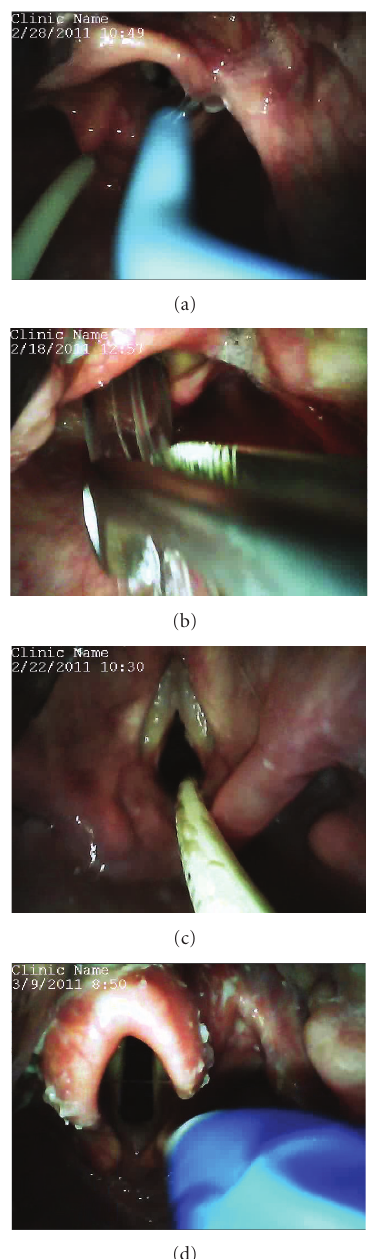
Figure 4: Examples of unique situations where the GlideScope Direct was found to be useful. (a) Endotracheal intubation with the aid of a bougie. (b) Nasotracheal Intubation with the use of Magill forceps. (c) Endotracheal tube exchange with the a Cook Airway Exchange Catheter. (d) Double-lumen endotracheal tube